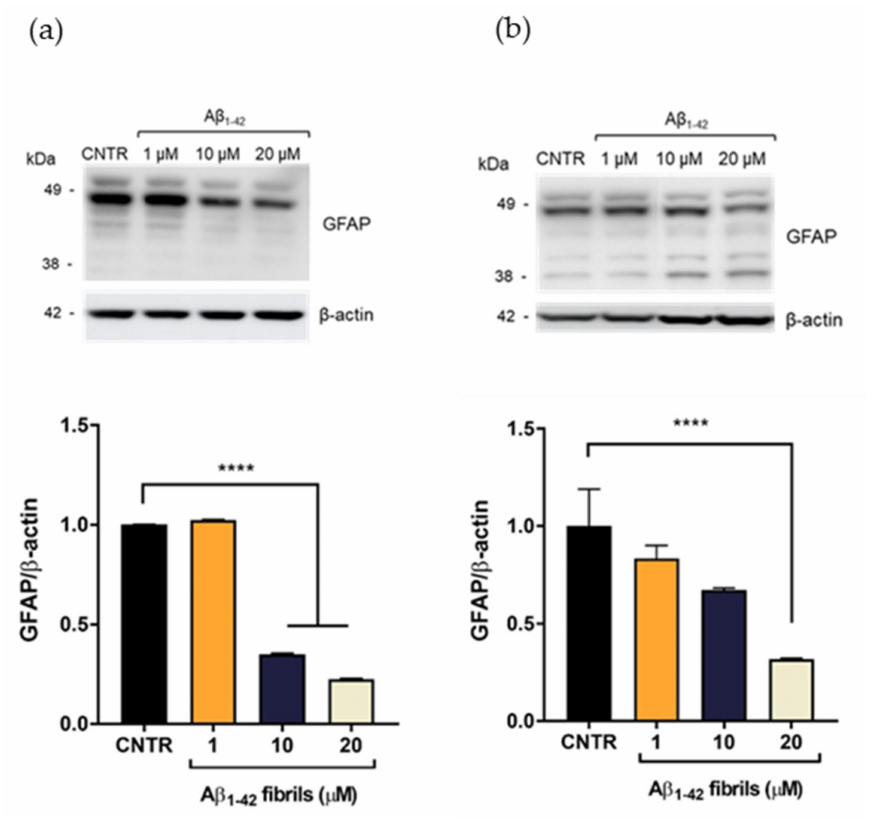
Figure 4. Quantification of GFAP expression levels in NHA after exposure to A β 1-42 fibrils via SDS- PAGE/WB. NHA cells were treated with a preparation of A β 1-42 , enriched in fibrils, at increasing concentrations (1 µ M, 10 µ M, and 20 µ M) for 24 ( a ) and 48 ( b ) h. The data are expressed as the mean of the samples in triplicate ± SEM; **** p < 0.0001 (one-way